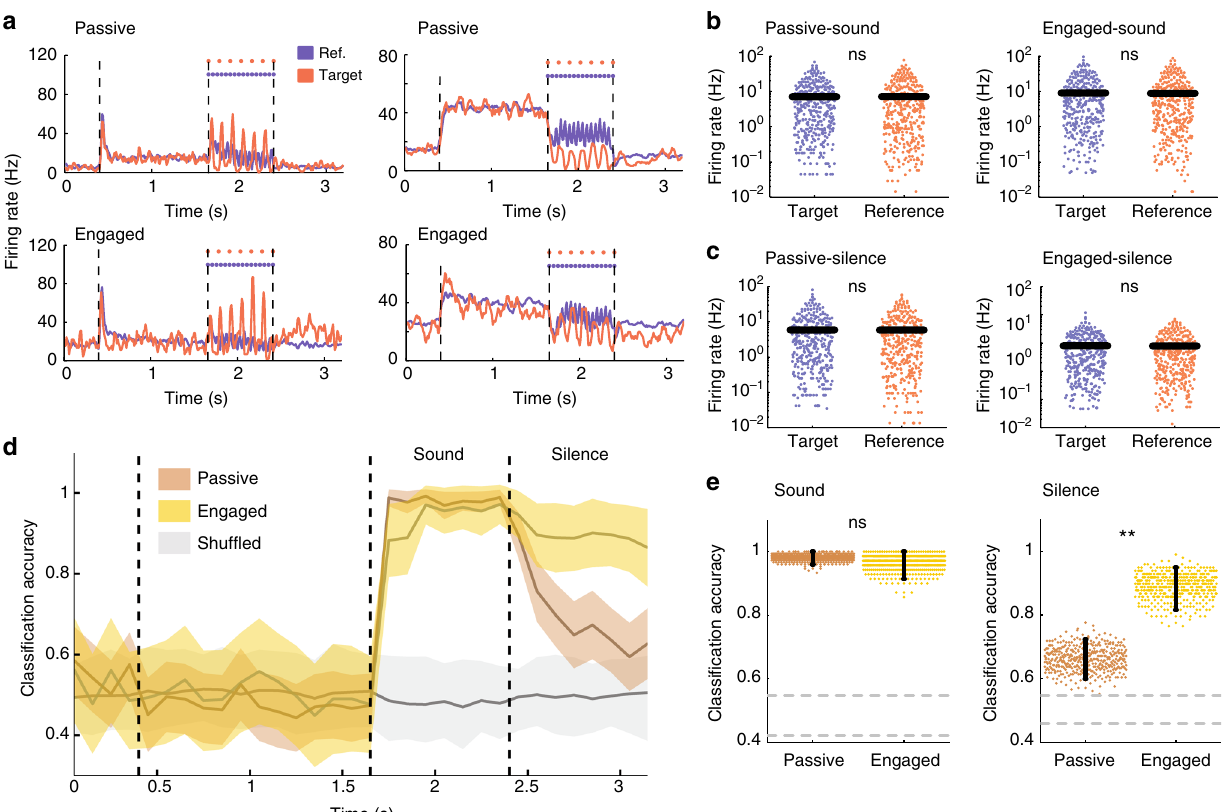
Fig. 2 Discrimination of target and reference stimuli based on A1 activity. a PSTHs of two example units during reference (blue) and target (red) trials in the passive (top) and task-engaged (bottom) state. The unit on the left is target-preferring and the unit on the right is reference-preferring. b , c Comparison of average fi ring rates on a log scale in passive (left) and engaged (right) between target and reference stimuli during the sound ( b ) and during the post-stimulus silence ( c ) periods. SEM error bars are not shown because it is not visible at this scale. (two-sided Wilcoxon signed rank, n = 370; zval = 0.34, p = 0.73; zval = 0.35, p = 0.79; zval = − 0.47, p = 0.64; zval = − 0.35, p = 0.73) ( d ) Accuracy of stimulus classi fi cation in passive and engaged states. In gray, chance-level performance evaluated on label-shuf fl ed trials. Error bars represent 1 std calculated over 400 cross-validations. e Mean classi fi er accuracy during the sound (left) and silence period (right) in both conditions. Gray dotted lines give 95% con fi dence interval of shuf fl ed trials. Error bars represent 95% con fi dence intervals. ( n = 400 cross-validations; p = 0.29 and p < 0.0025; ** p <